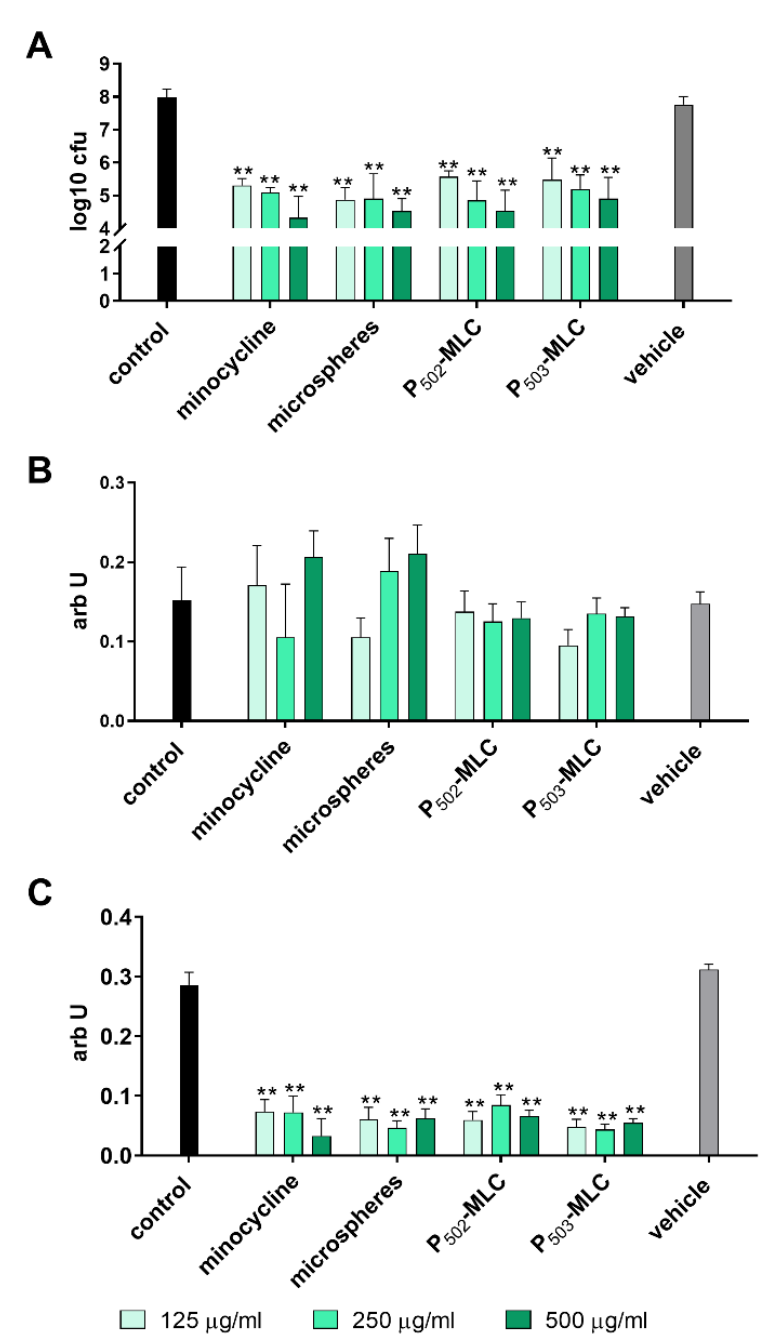
Figure 3. Activity of the minocycline formulations (substance (minocycl.) and microspheres (microsph.) polymer-lipid complex extrudate (PLM-C)) and PLM-C without minocycline (vehicle) on a six-species biofilm formed over 3.5 d. Bacterial counts determined as colony forming units (CFU) ( A ); biofilm quantity ( B ); and metabolic activity ( C ). ** p < 0.01 vs. control.